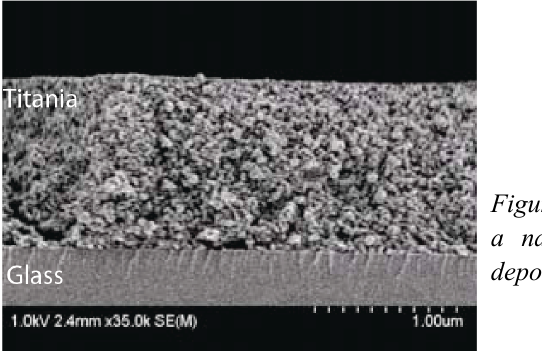
Figure 1. Cross sectional SEM picture of a nanoporous film of anatase titania deposited onto glass.